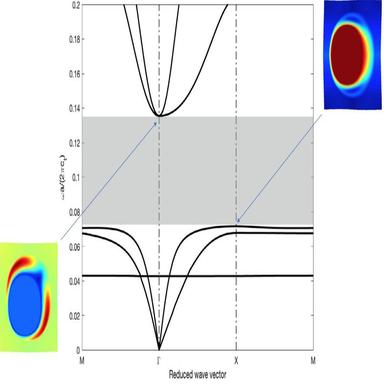
Detail of the dispersion curves showing band gap edge modes.